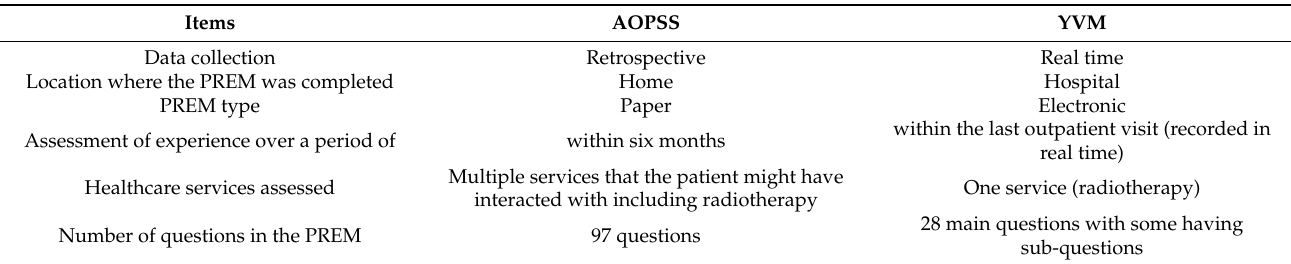
Table 1. Differences between the two